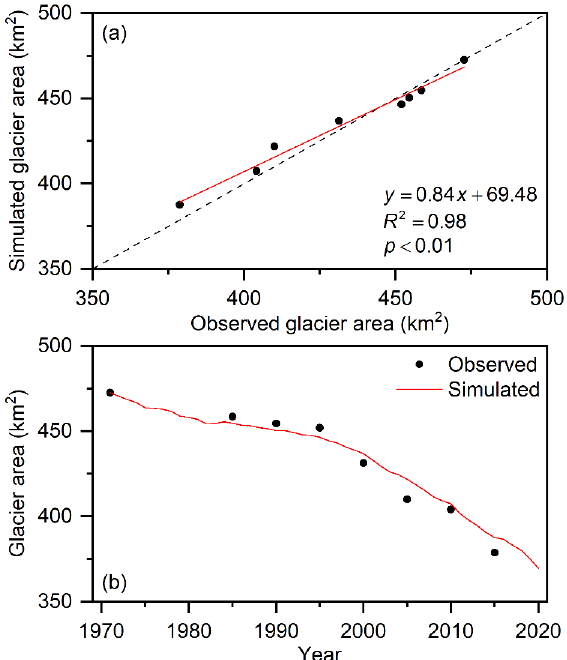
Figure 9. Comparison of the simulated glacier area and the extracted (observed) glacier area from a multi-period glacier inventory, and the change of the simulated glacier area in the USR in the past 50 years. ( a ) Simulated glacier area versus Observed glacier area; ( b ) Simulated glacier area from 1971 to 2020.